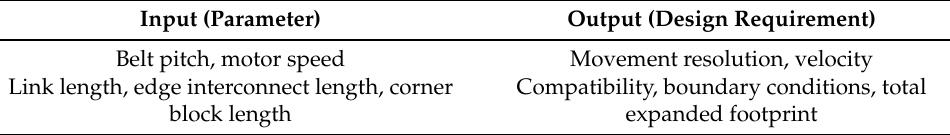
Table 3. Design inputs and outputs.